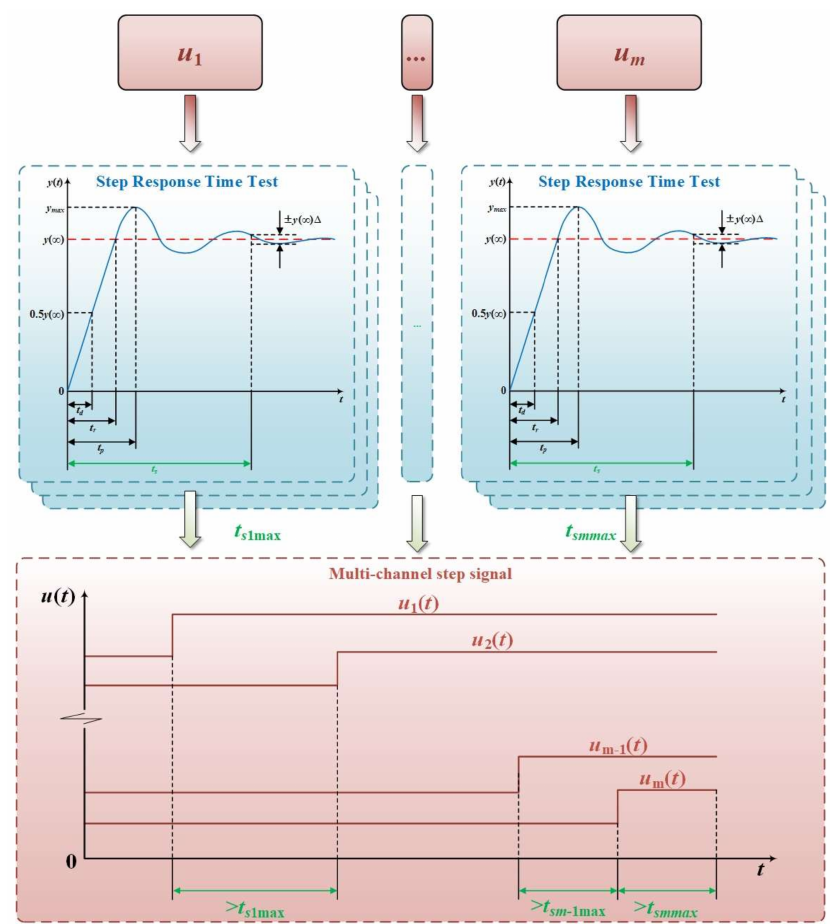
Figure 5. Multi-channel step signal construction